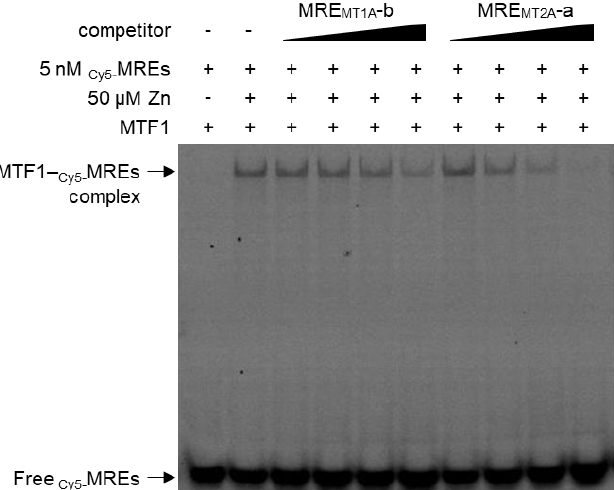
Figure 5. The MRE MT1A and MRE MT2A competitive effects on the binding reaction between MTF1 and MREs were examined via EMSA analysis. MTF1 protein was synthesized in a coupled transcrip- tion/translation reaction and incubated in a buffer containing 50 µM zinc. EMSA reactions were carried out containing competitive DNAs at 5, 100, 250, and 1000 nM. Binding of MTF1 to MREs was visualized by detecting Cy5-floorescence as low mobility MTF1– Cy5 -MREs complex